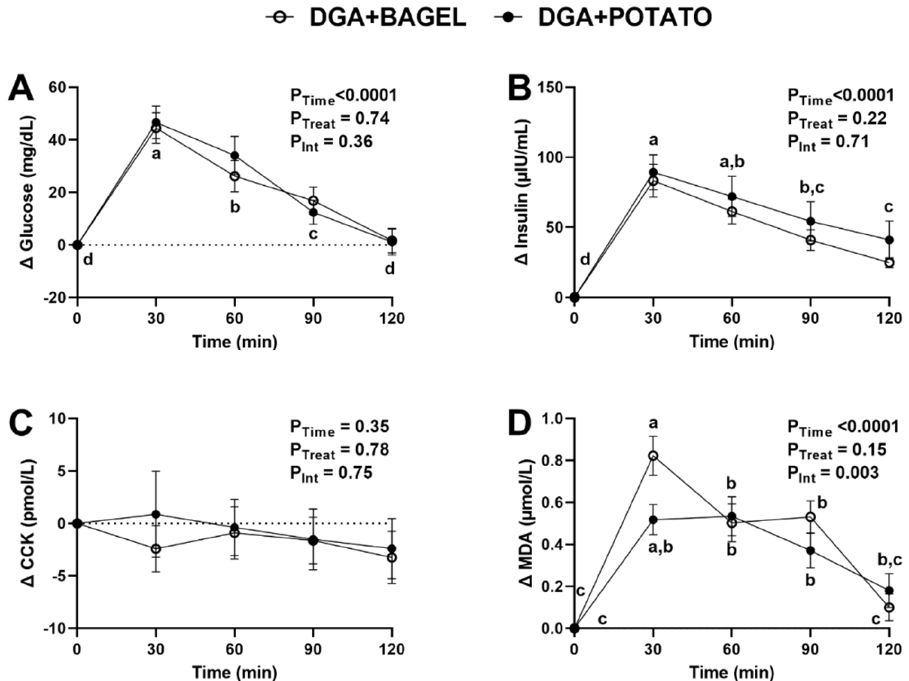
Figure 2. Plasma metabolic excursions in MetS persons who followed a DGA -based diet containing potatoes (DGA + POTATO) or bagels (DGA + BAGEL) for 2 weeks prior to completing a glucose tolerance test. ( A ) Plasma glucose, ( B ) insulin, ( C ) CCK, and ( D ) MDA during a 2-h postprandial period following the ingestion of 75 g of glucose. Data (means ± SE, n = 27) are expressed as changes from baseline (0 min) and were analyzed by 2-way RM ANOVA with Bonferroni’s post-test to assess effects due to time, treatment, and their interaction. p < 0.05 was considered statistically significant, and data are annotated (a > b > c) to visualize post-hoc effects due to time or time x treatment as appropriate. Abbreviations: CCK, cholecystokinin; DGA , Dietary Guidelines for Americans ; MDA, malondialdehyde; and MetS, metabolic syndrome. Table 4. AUC 0–120 min for cardiometabolic health in MetS persons who were provided a DGA-based diet containing a daily serving of bagel (DGA + BAGEL) or potato (DGA + POTATO) for 2 weeks prior to receiving an oral glucose tolerance test and assessing postprandial responses at 30 min intervals for 2 h 1,2 .